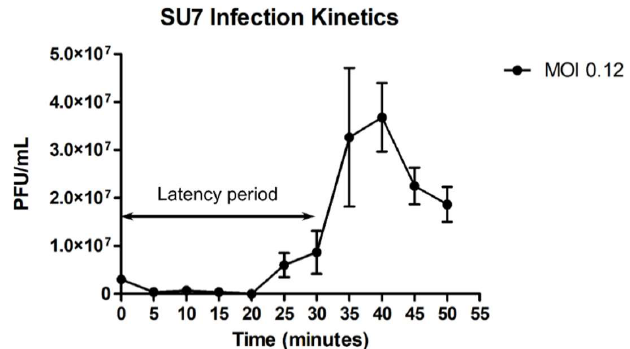
Figure 2. One-step growth curve of phage SU7 infecting bacterial ETEC7 at an MOI of 0.12. After one round of infection, SU7 has a latency period of 30 min, a burst size of 12 PFU/cell, and an adsorption rate constant of 8.78 × 10 − 9 mL/min five minutes post infection. Data points represent the mean of three independent experiments and error bars represent the standard error of each